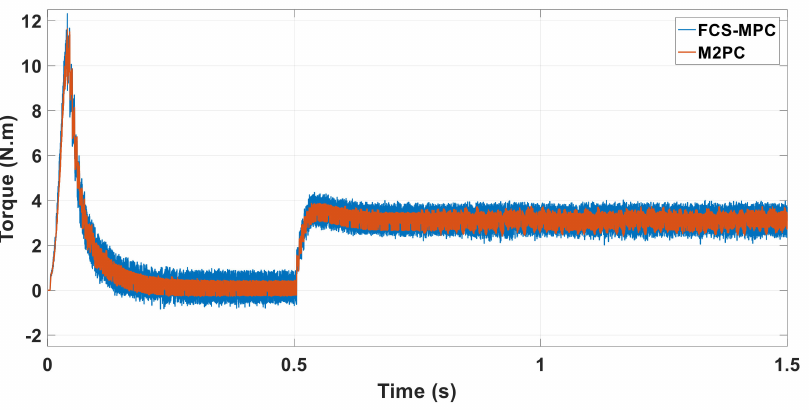
Figure 4. The comparison of oscillations in the electromagnetic torque for both control